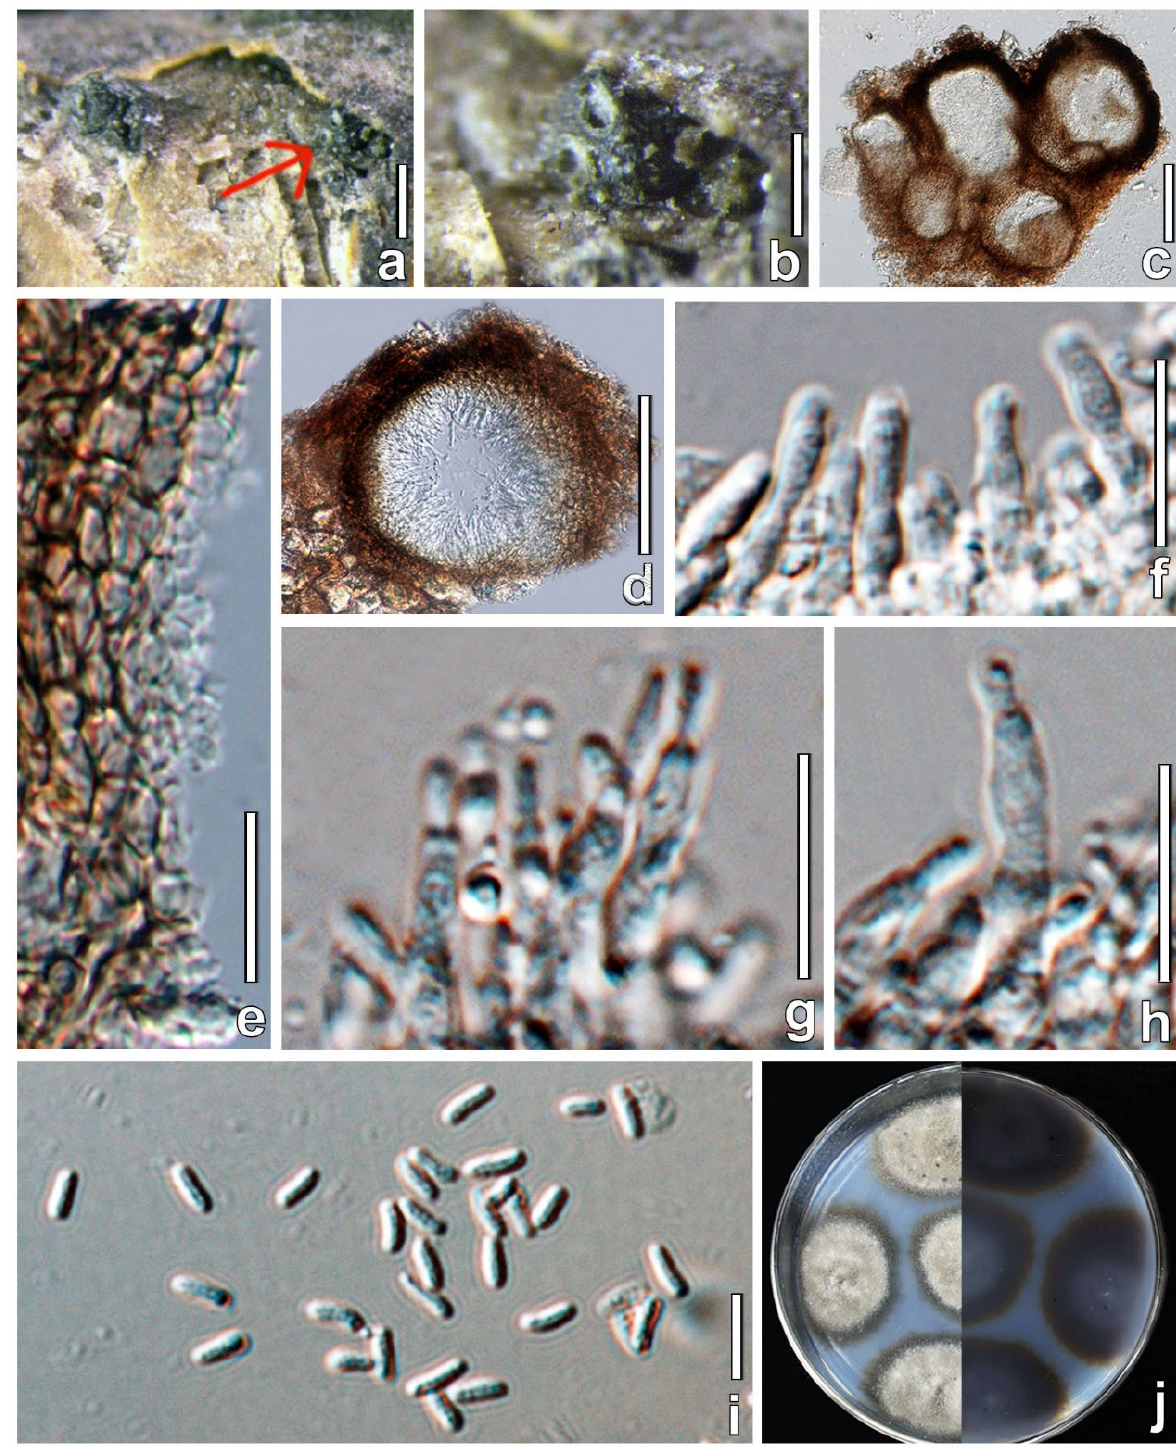
Figure 3. Allocucurbitaria mori (HMJAU 60183, holotype) The red arrow indicates the conidiomata in face view. ( a , b ) Appearance of conidiomata on host substrate. ( c , d ) Vertical section of partial conidiomata. ( e ) Section of partial conidioma wall. ( f – h ) Conidiogenous cells and conidia. ( i ) Conidia. ( j ) Culture characteristics on PDA. Scale bars: ( a ) = 500 μ m; ( b ) = 200 μ m; ( c , f ) = 100 μ m; ( d ) = 50; ( e , g , h ) = 10 μ m; ( i ) = 5 μ m.